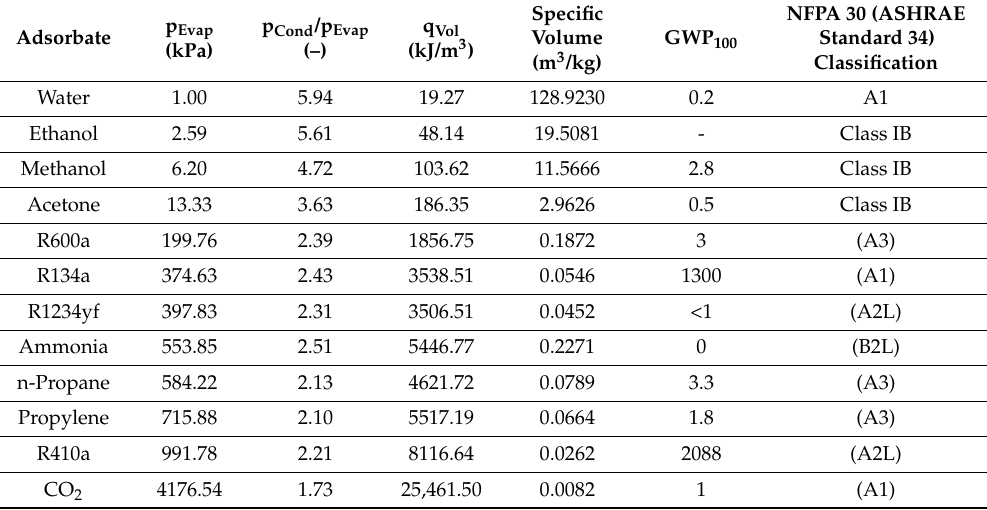
Table 4. Parameters of some refrigerants